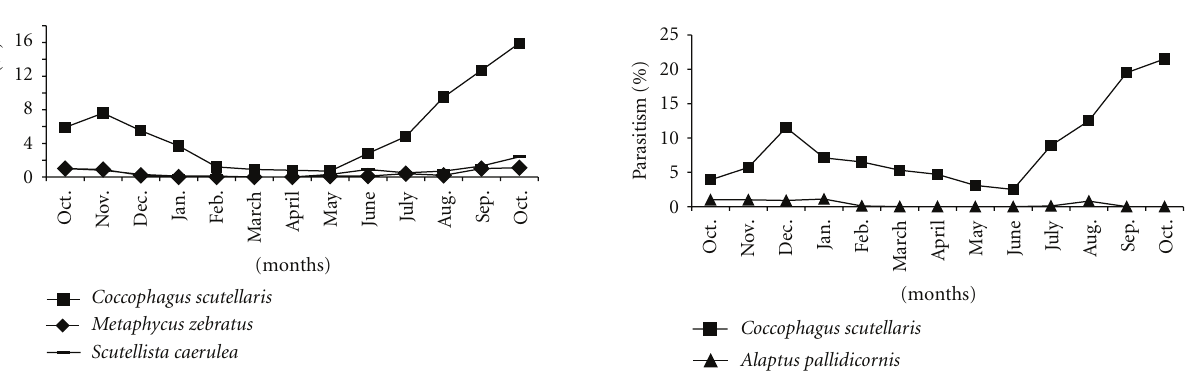
Figure 5: Percent parasitism of Coccophagus scutellaris and other associated parasitoid of Coccus hesperidum on guava in Giza governorate after releasing during 2009-2010.